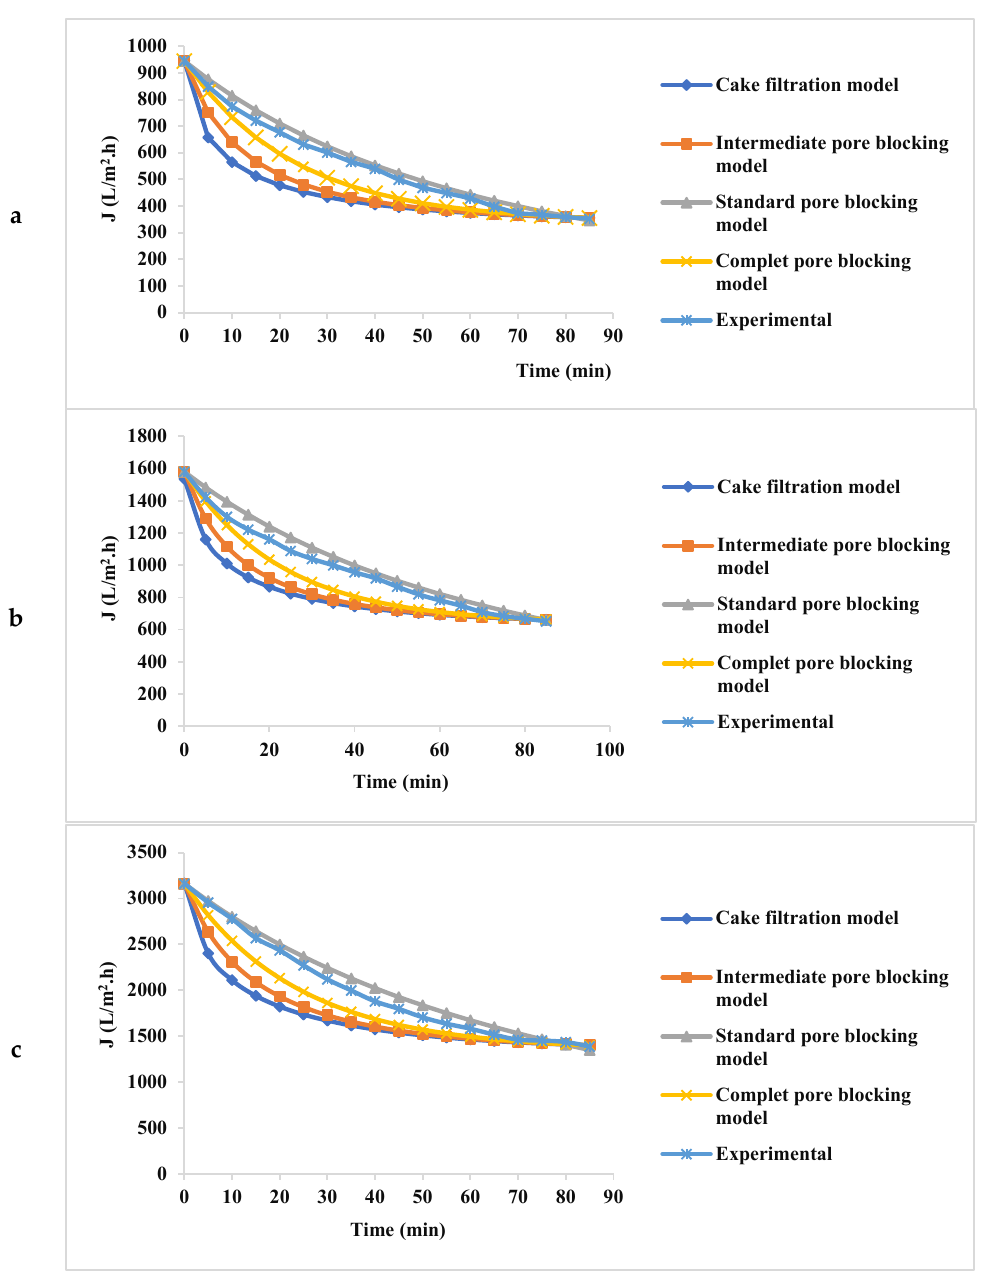
Figure 12. Variations of experimental and predicted J decline for ( a ) M, ( b ) M/SiC30, and ( c )